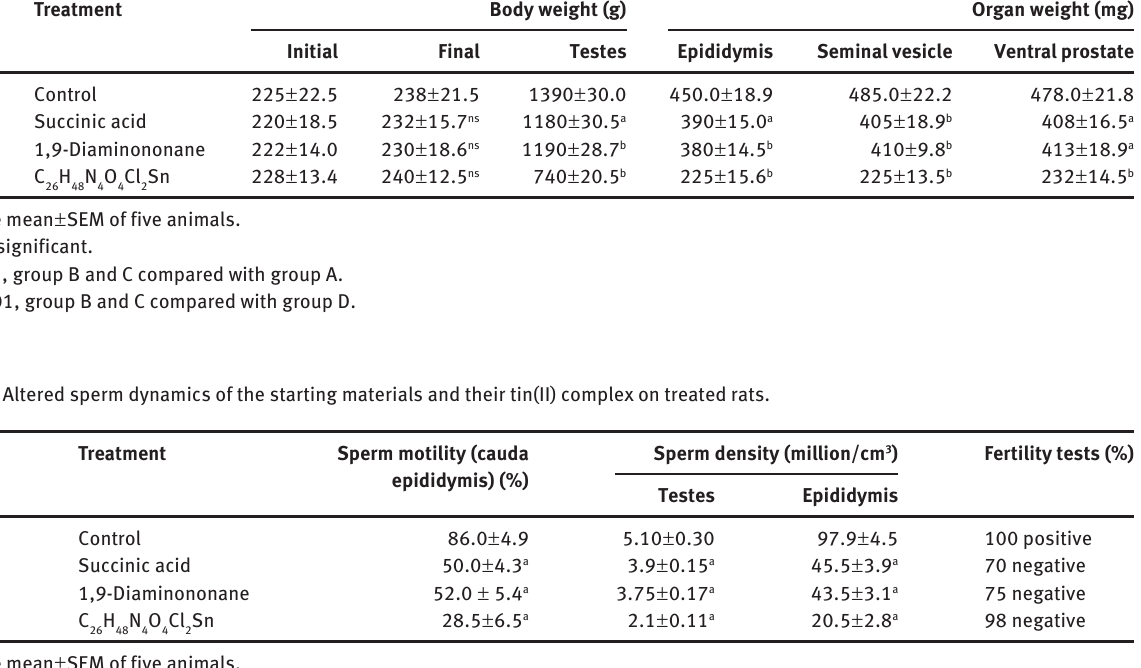
Table 6 Effect of starting materials and their tin(II) complex on body and reproductive organ weights of male rats. Groups Treatment Body weight (g)